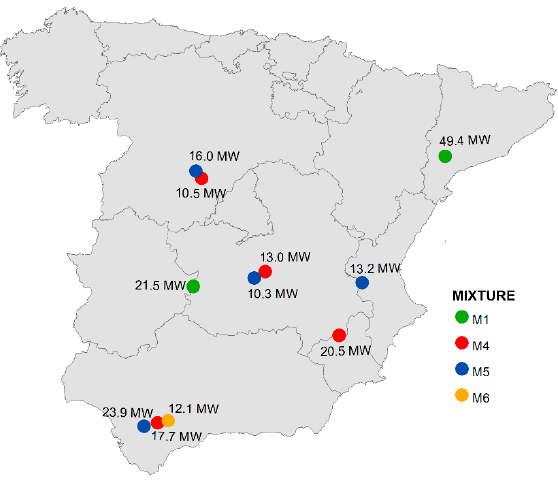
Figure 9. Geographical distribution of the proposed feasible power plants.